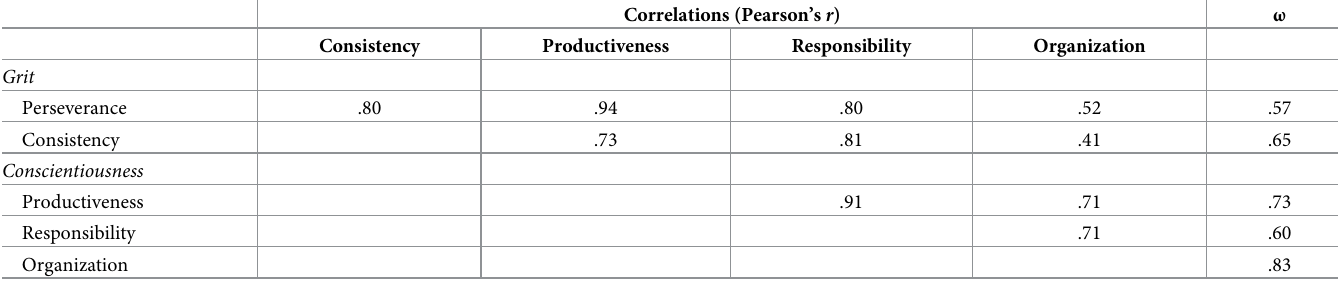
Table 1. Latent correlations and reliabilities ( ω ) for the facets of Grit and Conscientiousness in the correlated first-order factors model (Model